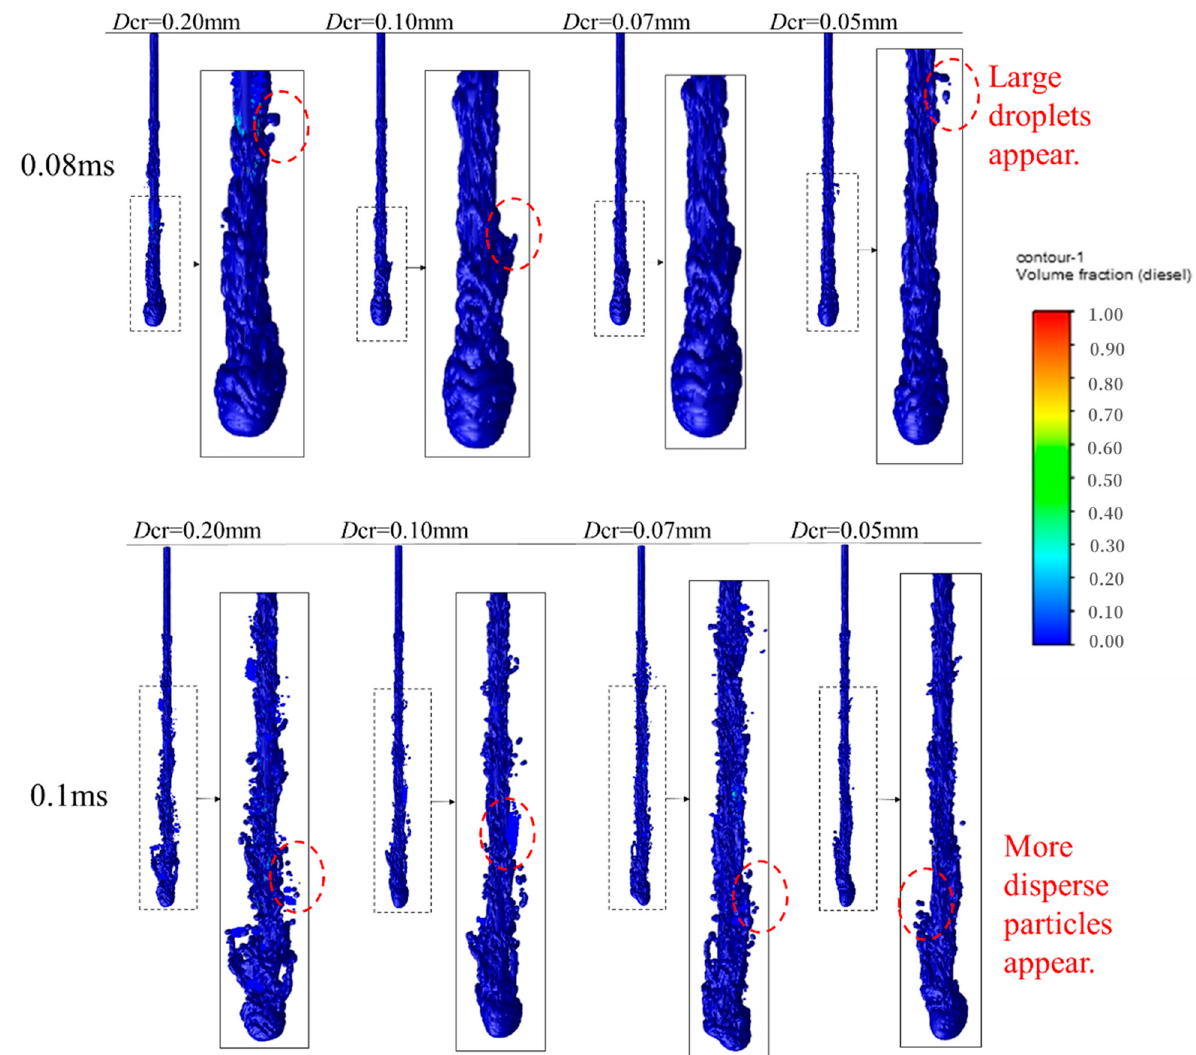
Figure 11. Primary breakup of fuel spray. Figure 12 shows the details of the spray cone angle, θ . For both the test data and model results, the spray cone angle rises to a maximum early on and then decreases. For different transition standard particle diameters, D cr , the spray cone angles become different. Furthermore, the value of the transition standard particle diameter D cr = 0.10 mm is closest to the test